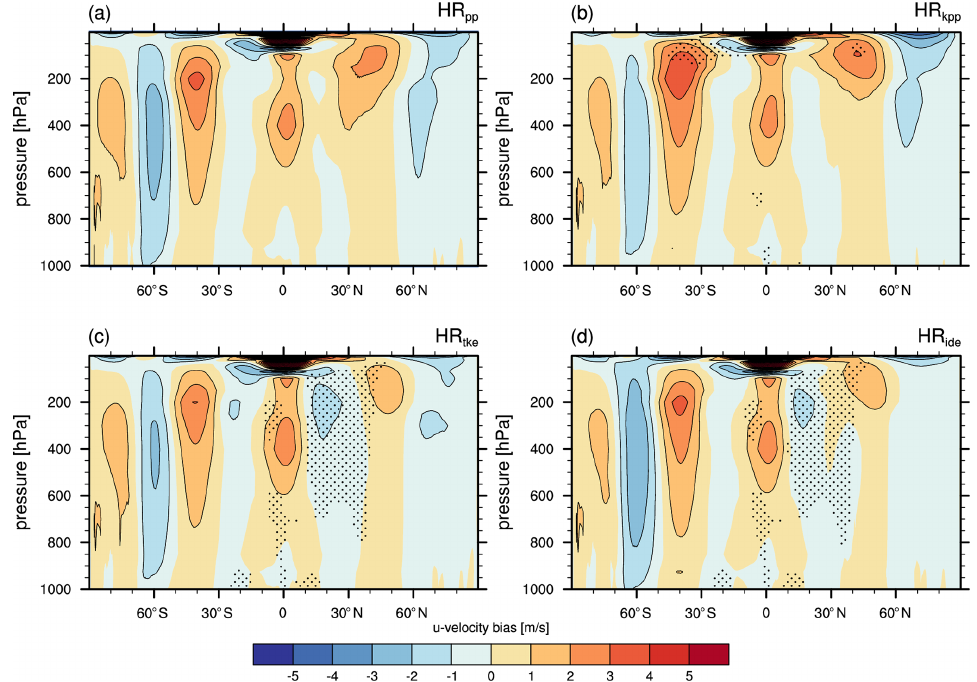
Figure 19. Time-averaged zonal wind speed bias (MPI-ESM1.2 minus EN4) for (a) HR pp , (b) HR kpp , (c) HR tke , and (d) HR ide . Stippling in panels (a) – (c) shows where the difference to HR pp is significant at α = 5% based on adjusted p values with the FDR method (Benjamini and Hochberg, 1995) using α FDR = 5% to account for